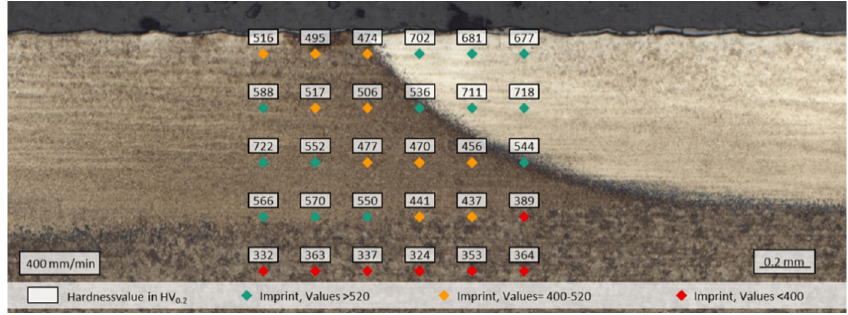
Figure 14. Hardness distribution in the track overlap region for the code case of 400 mm/min.